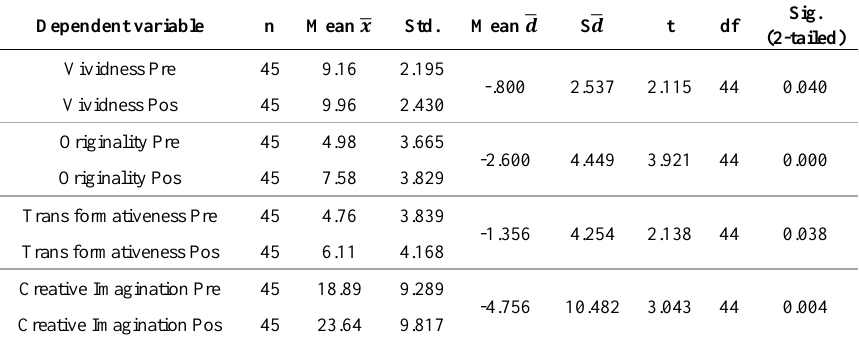
Table 4. Results of analysis of dependent t-test of the sample group of 45